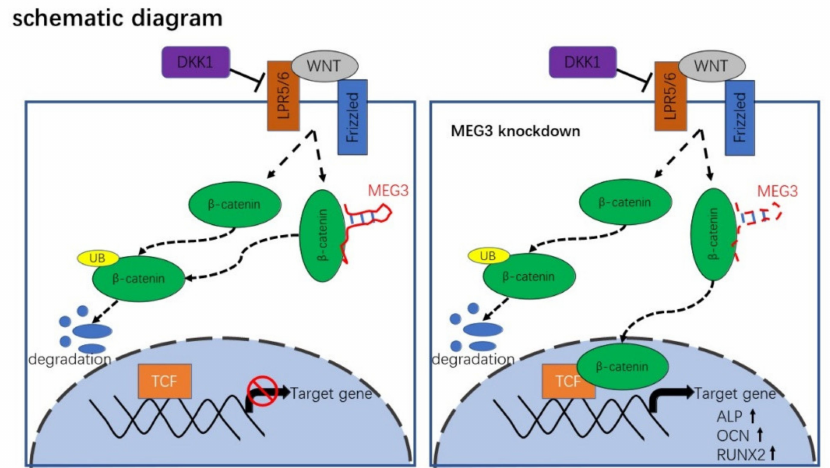
Scheme 1. Scheme diagram of MEG3 knockdown promotes osteogenic differentiation of BMSCs by activating Wnt/ β -catenin